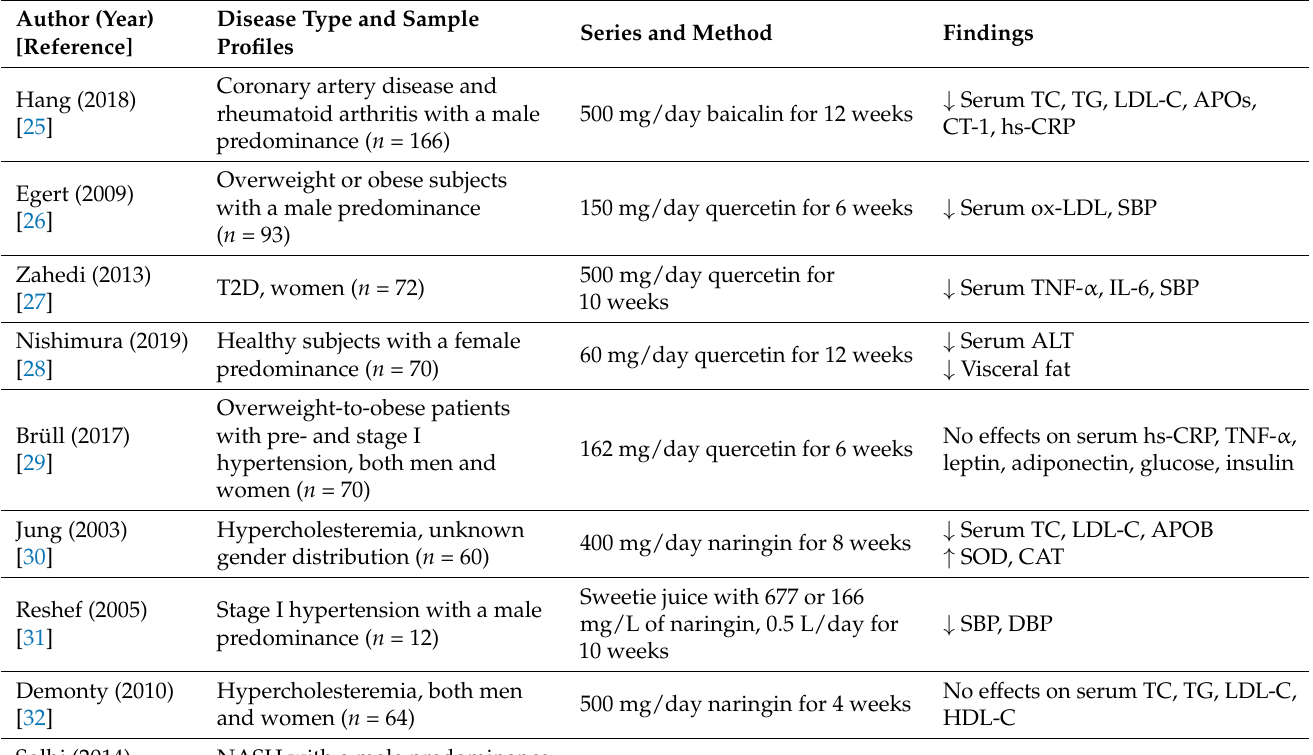
Table 1. Local clinical trials with natural polyphenols on MetS and its